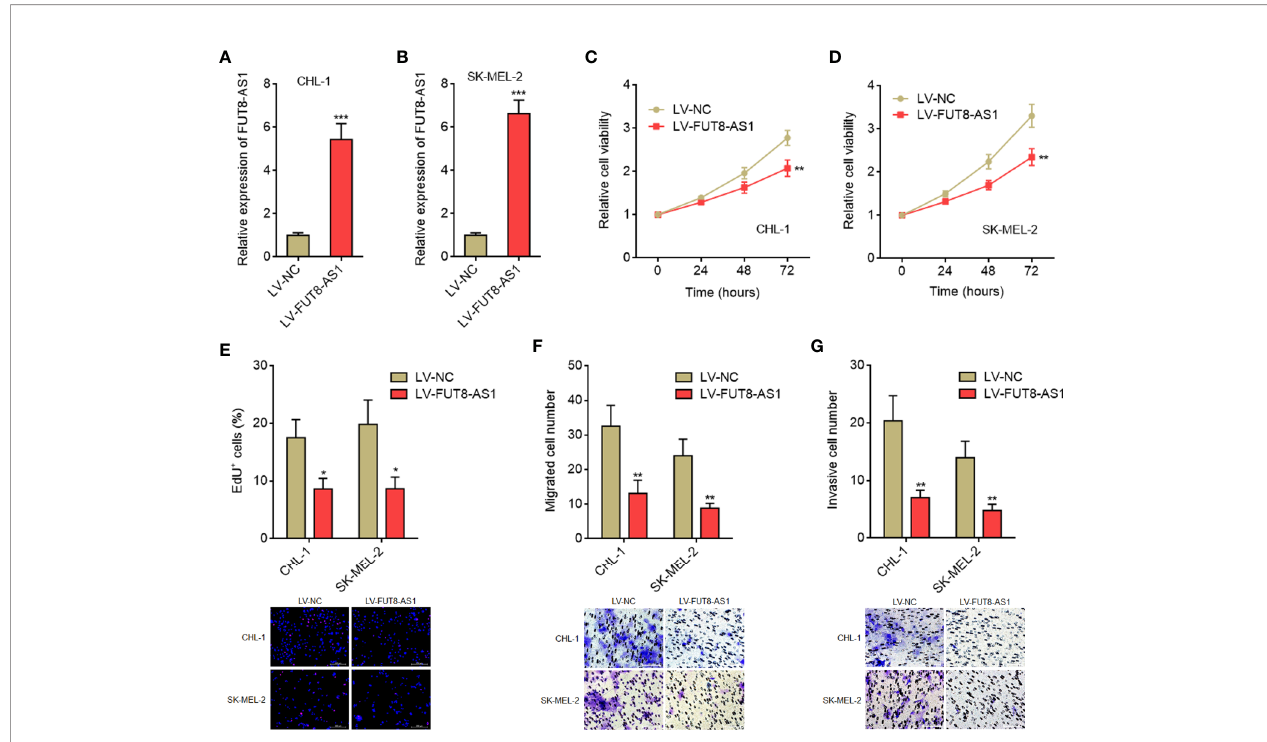
FIGURE 2 | FUT8-AS1 inhibits melanoma cell proliferation, migration, and invasion. (A) FUT8-AS1 expression in CHL-1 cells overexpressing FUT8-AS1or control was measured by real-time PCR. (B) FUT8-AS1 expression in SK-MEL-2 cells overexpressing FUT8-AS1 or control was measured by real-time PCR. (C) Cell viabilities of CHL-1 cells overexpressing FUT8-AS1 or control were determined by the Glo cell viability assay. (D) Cell viabilities of SK-MEL-2 cells overexpressing FUT8-AS1 or control were determined by the Glo cell viability assay. (E) Cell proliferation of CHL-1 and SK-MEL-2 cells overexpressing FUT8-AS1 or control were determined by the EdU incorporation assay. The red color indicates EdU-positive nuclei. Scale bars, 200 µm. (F) Cell migration of CHL-1 and SK-MEL-2 cells overexpressing FUT8-AS1 or control were determined by the transwell migration assay. Scale bars, 100 µm. (G) Cell invasion of CHL-1 and SK-MEL-2 cells overexpressing FUT8-AS1 or control were determined by the transwell invasion assay. Scale bars, 100 µm. Data are presented as mean ± SD. * P < 0.05, ** P < 0.01, *** P < 0.001 by two-tailed unpaired t